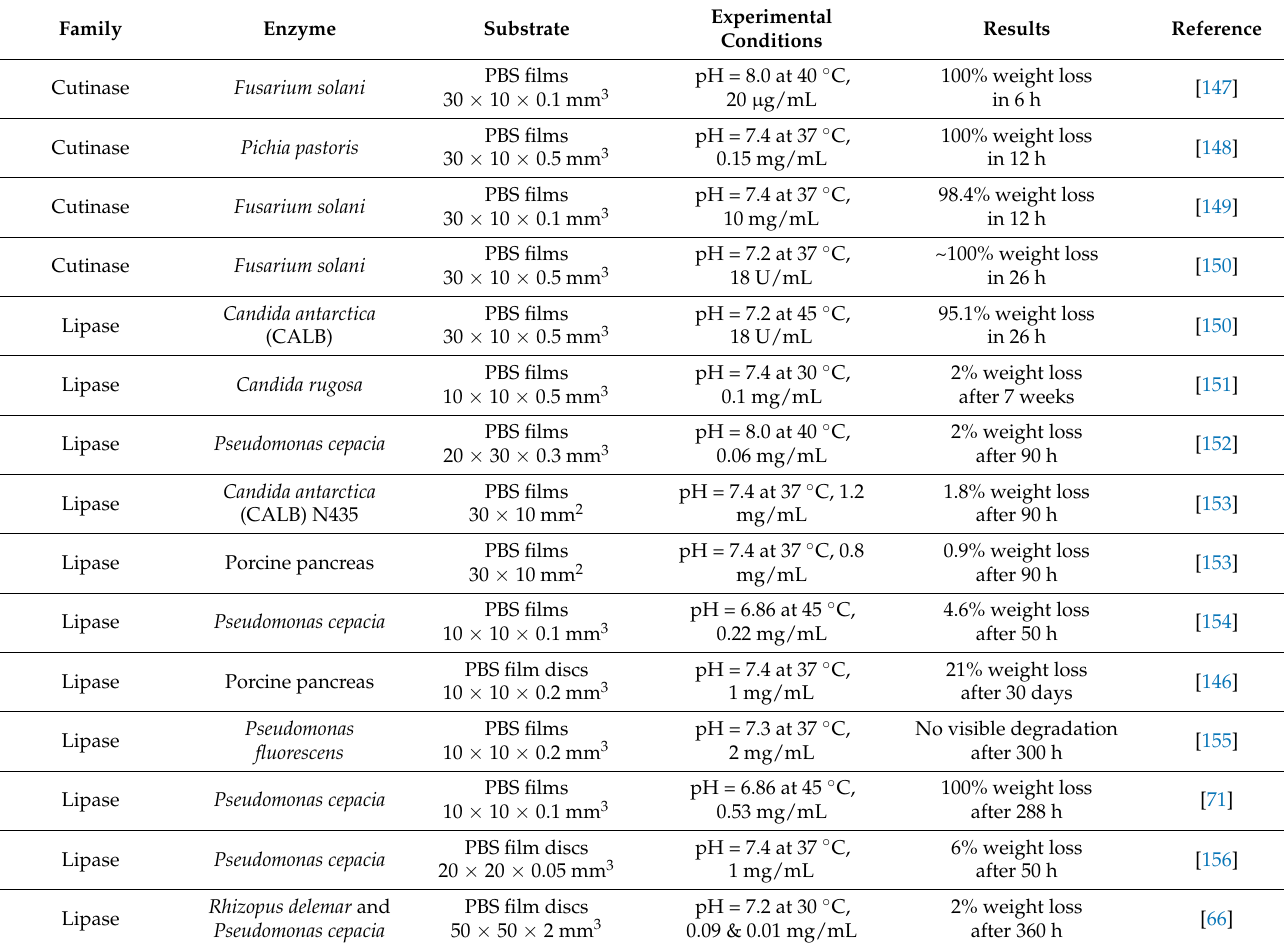
Table 1. Classification of enzymes by families for different PBS enzymatic degradation